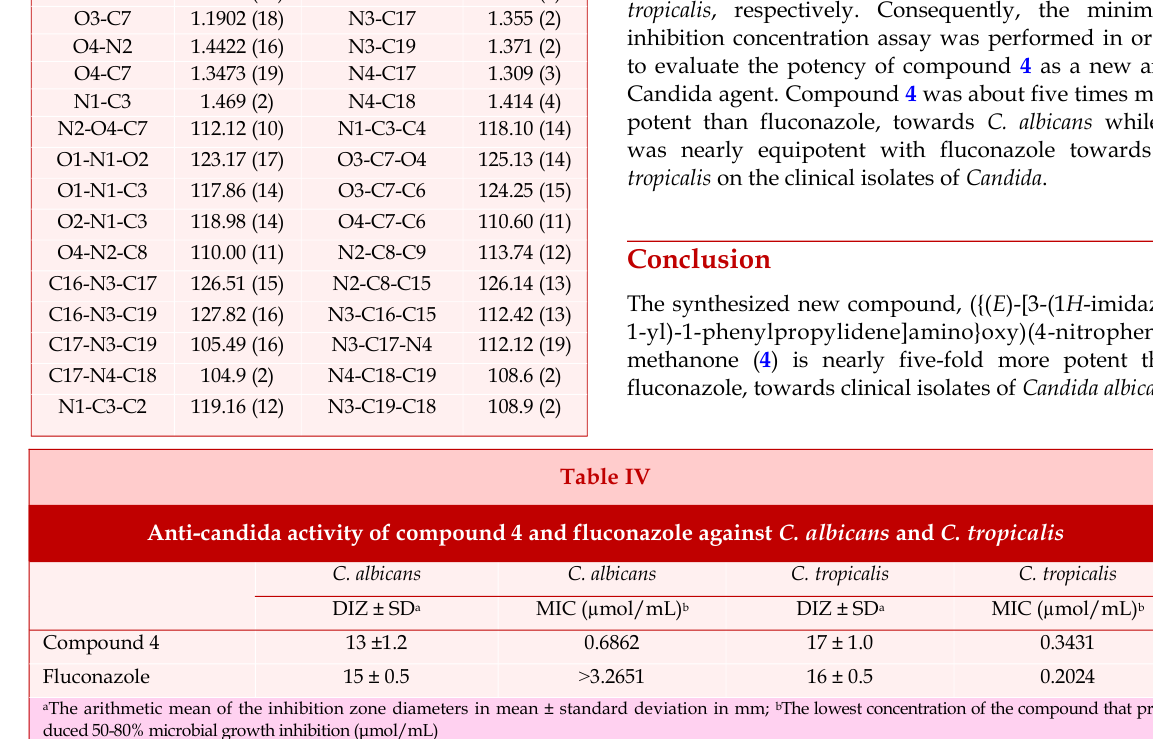
Selected geometric parameters (Å, °)